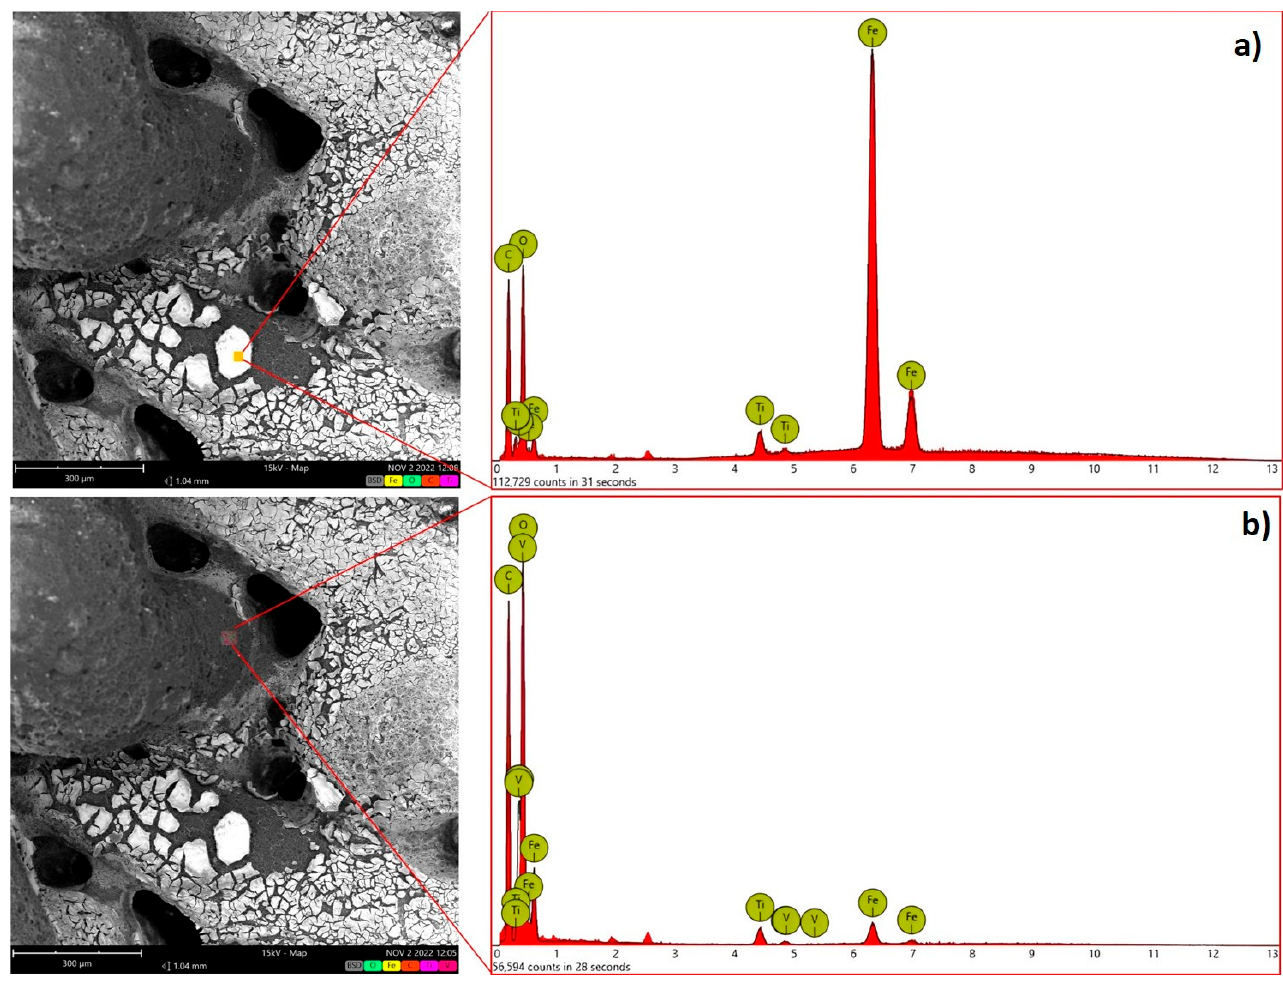
Figure 2. Left: SEM picture of the catalyst. Right: EDX analysis is shown at two different areas characterized by a different content of Fe. ( a ) analysis of first mapping; ( b ) analysis of second mapping Table 1. Average atomic concentration of the main elements as determined by EDX analysis reported in Figure 2a,b.